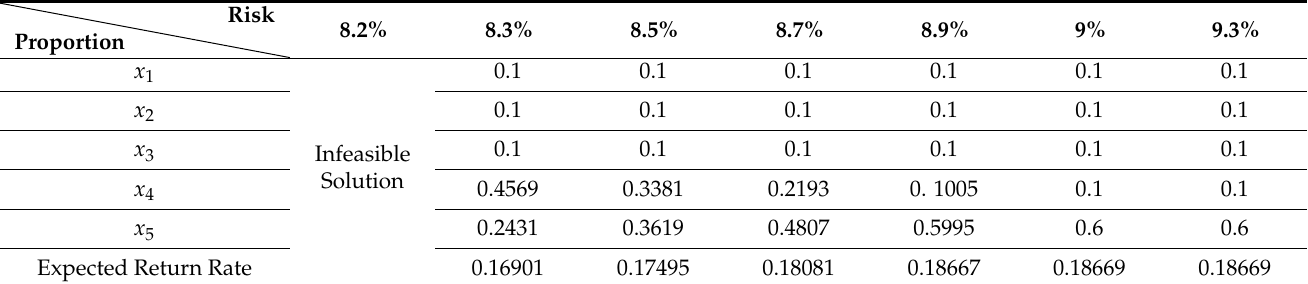
Table 2. The efficient portfolio with s = 2 in a guaranteed return rate (cid:101) p 2 .